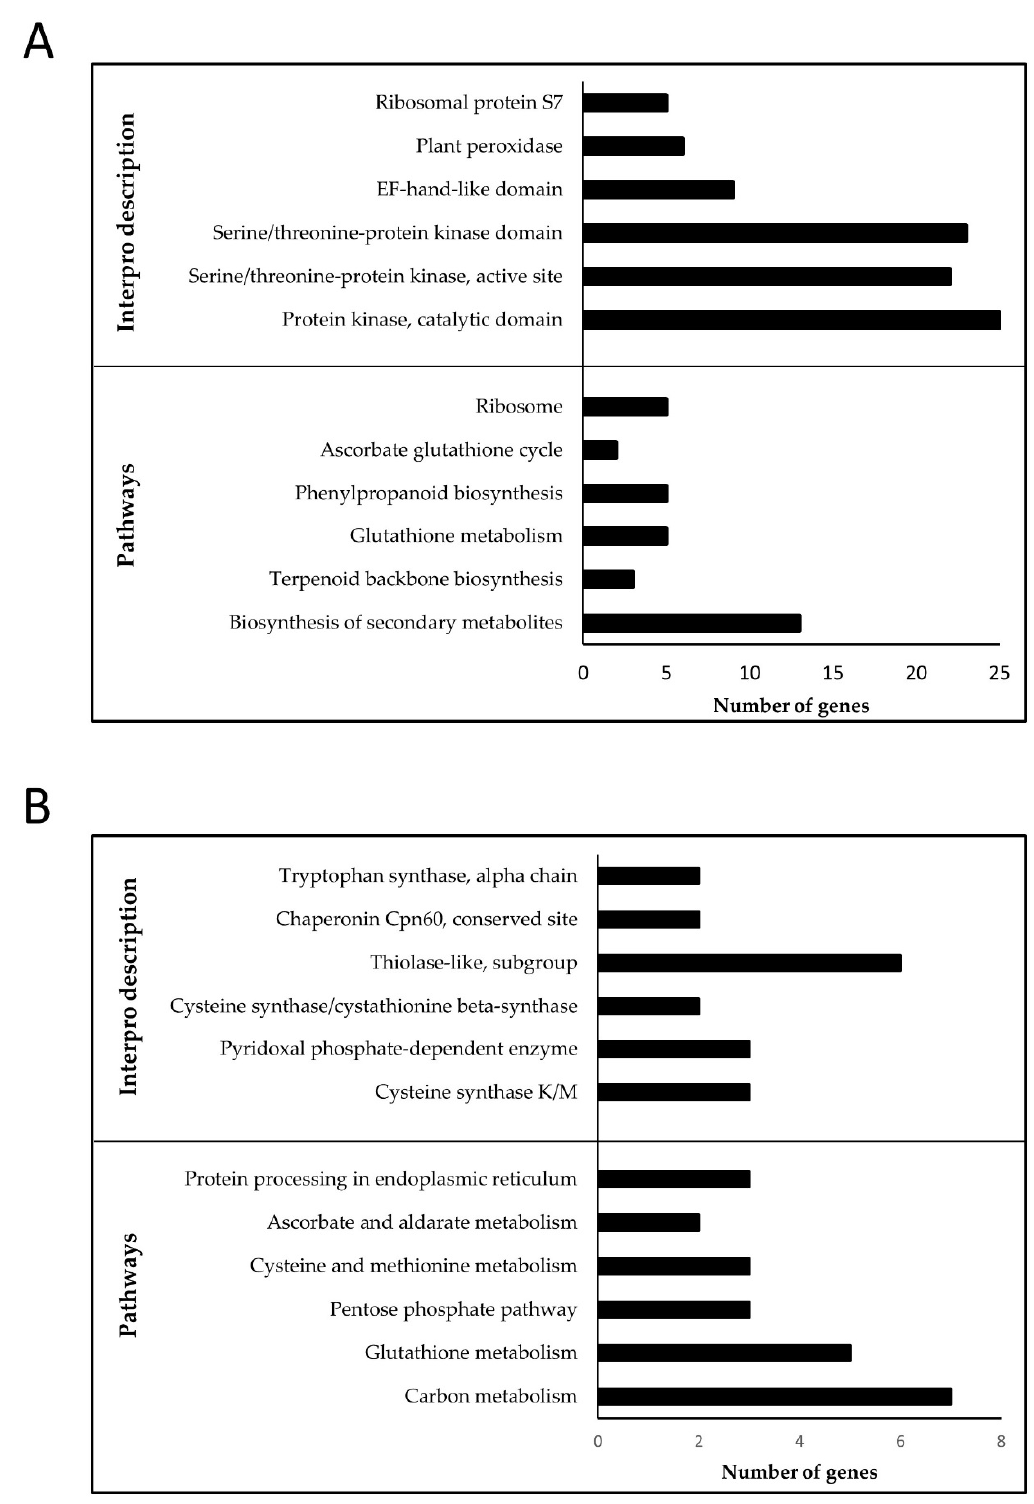
Figure 8. Enrichment analysis of the functional categories in P-M10 and P-M15. Over-represented Interpro domains and enriched pathways in P-M10 ( A ) and P-M15 ( B ) in panicle under RDS. Top significant pathways and Interpro domains are shown in Y -axis with the number of represented genes on the X -axis.